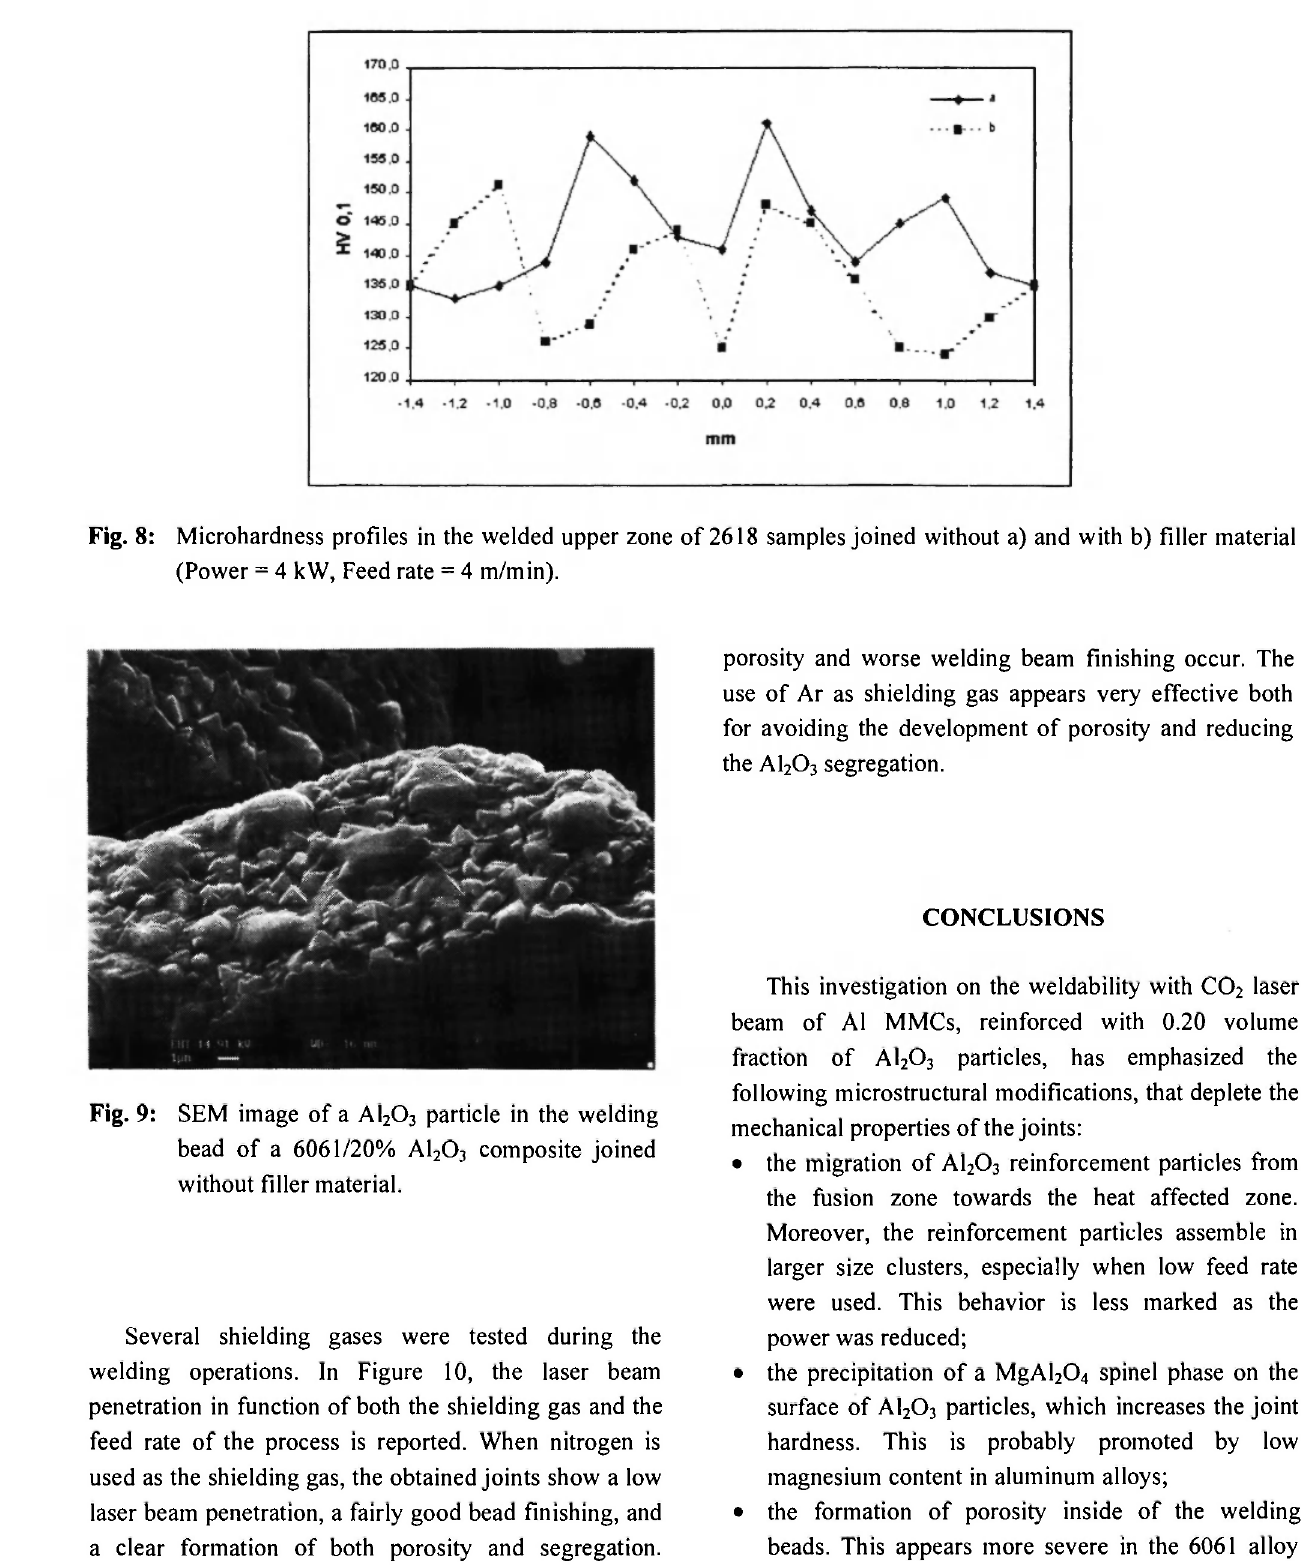
Fig. 9: SEM image of a A1 2 0 3 particle in the welding bead of a 6061/20% A1 2 0 3 composite joined without filler